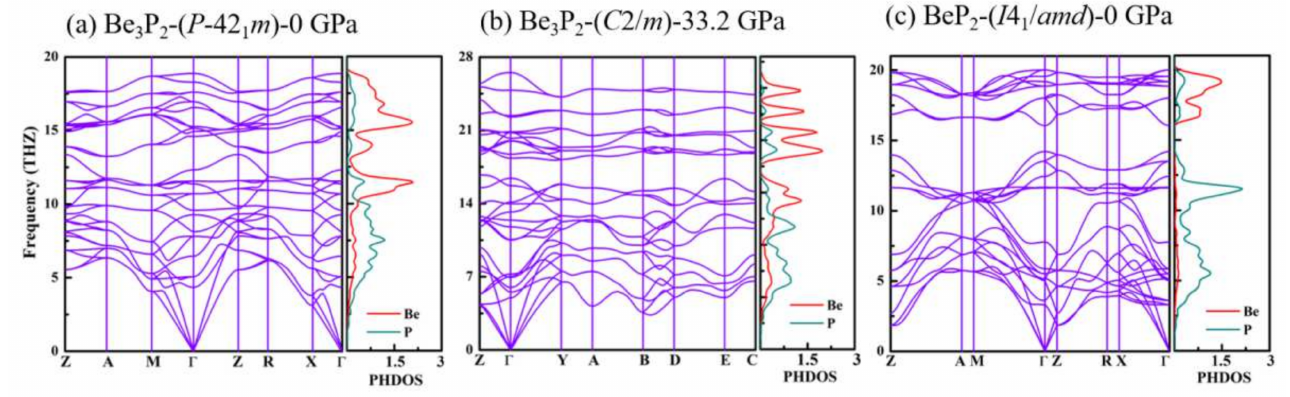
Figure 4. (color online). Phonon − dispersion contours and PHDOS projected on Be and P atoms for ( a ) Be 3 P 2 − P − 42 1 m at 0 GPa, ( b ) Be 3 P 2 − C 2/ m at 33.2 GPa, and ( c ) BeP 2 − I 4 1 / amd at 0